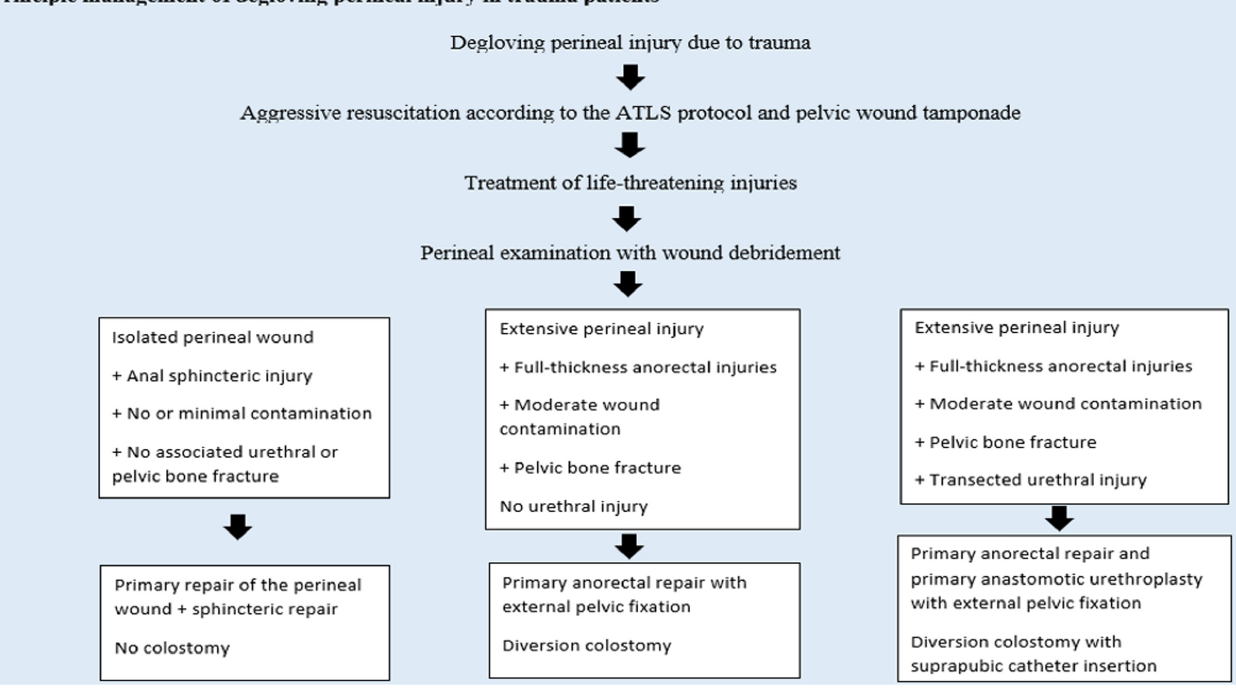
Figure 1. Principle management of degloving perineal injury in trauma